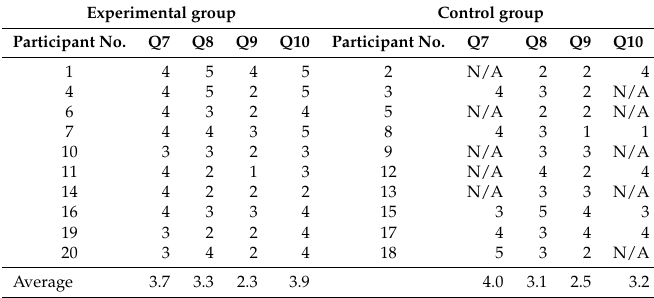
Table 5. Post-survey results comparison on questions